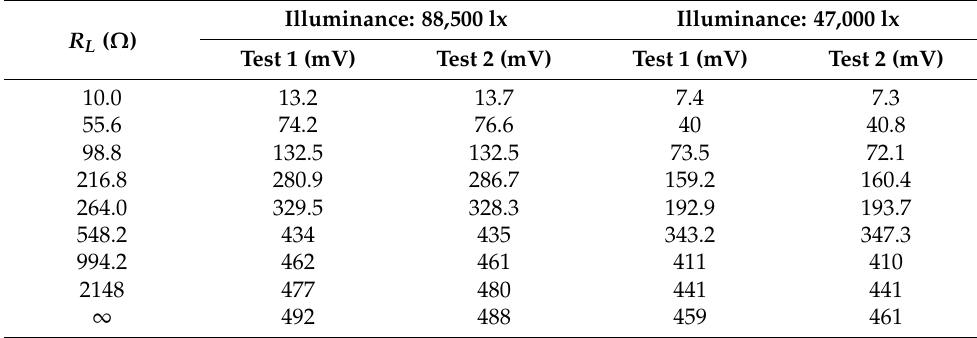
Table 1. Experimental measurements of the I – V curve of the photodiode SS1-X+. R L ( Ω